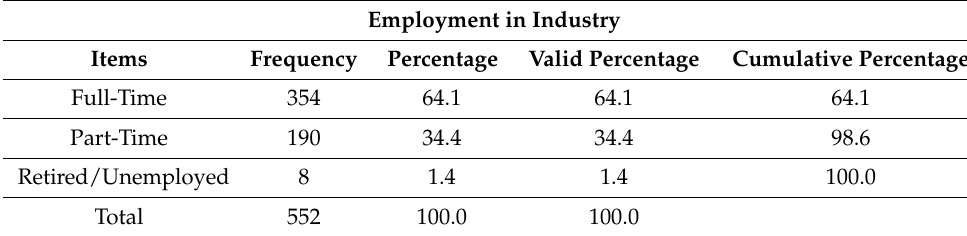
Table 4. Demographic information of the respondents by employment in the industry.